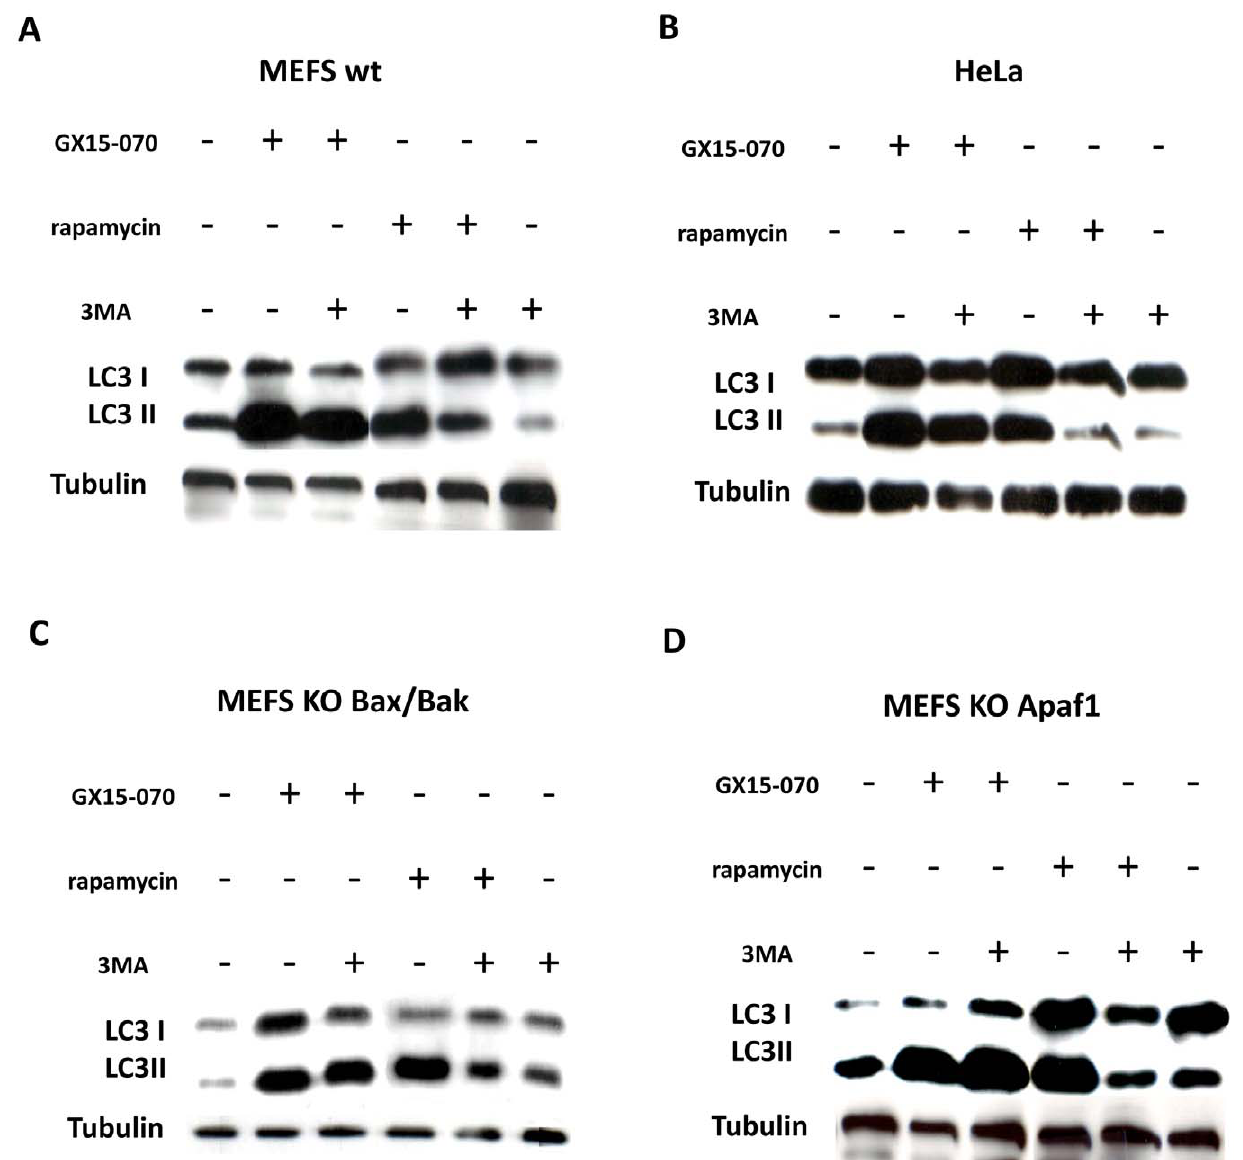
Figure 6. GX15-070 activates Beclin-1 non-dependent autophagy in all the cell lines. ( A–D ) LC3 immunoblotting in the MEFS wt Apaf-1, MEFS KO Apaf-1, MEFS KO Bax/Bak and HeLa cell lines treated with rapamycin (30 m M) and GX15-070 (1 m M) for 24 h in the presence or absence of 3MA (10 mM).